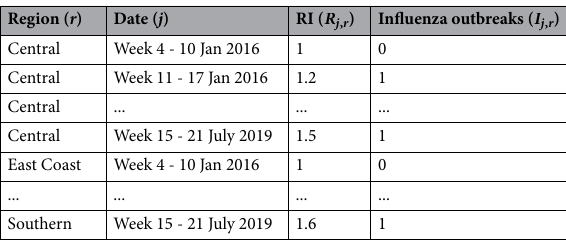
Table 6. Diagnostic data with labelled influenza outbreaks.